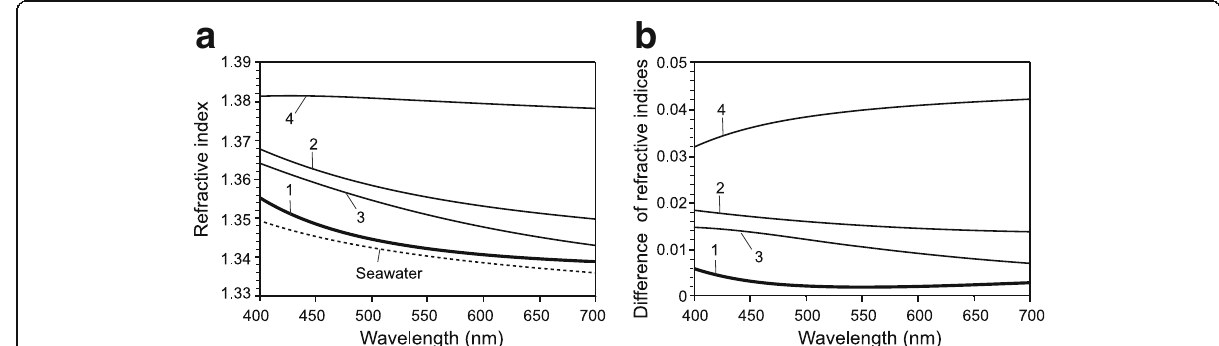
Fig. 3 Refractive indices estimated by ellipsometry. a Refractive indices of seawater (dotted line), the tunic of Pegea confoederata with mantle (1, thick line) and the tunic without mantle (2 – 3, thin lines). The refractive index of seawater (35 ‰ , 25 °C) is calculated from the equation [14] that is valid from 400 nm to 700 nm. b Difference in refractive indices between the tunic specimens and seawater